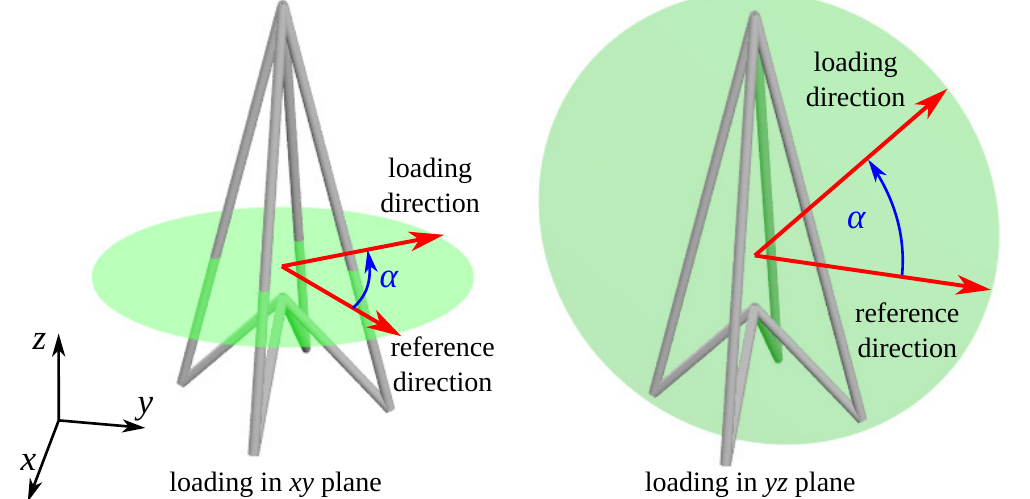
Figure 3. Diagram portraying xy and yz planes in which different uniaxial loading directions were considered. Note that the “reference” direction of loading which is being used to calculate the value of α should be adjusted depending on the particular mechanical property; e.g., it should be rotated by 90 ◦ around the y axis to obtain ν xz from ν zx , etc. Additionally, to denote the Poisson’s ratio for loading in the arbitrary direction for example in the xy plane, the notation ν xy ( α ) is used which indicates that the loading and transverse deformation directions are defined in the xy plane but are rotated by the angle α with respect to the x and y axes